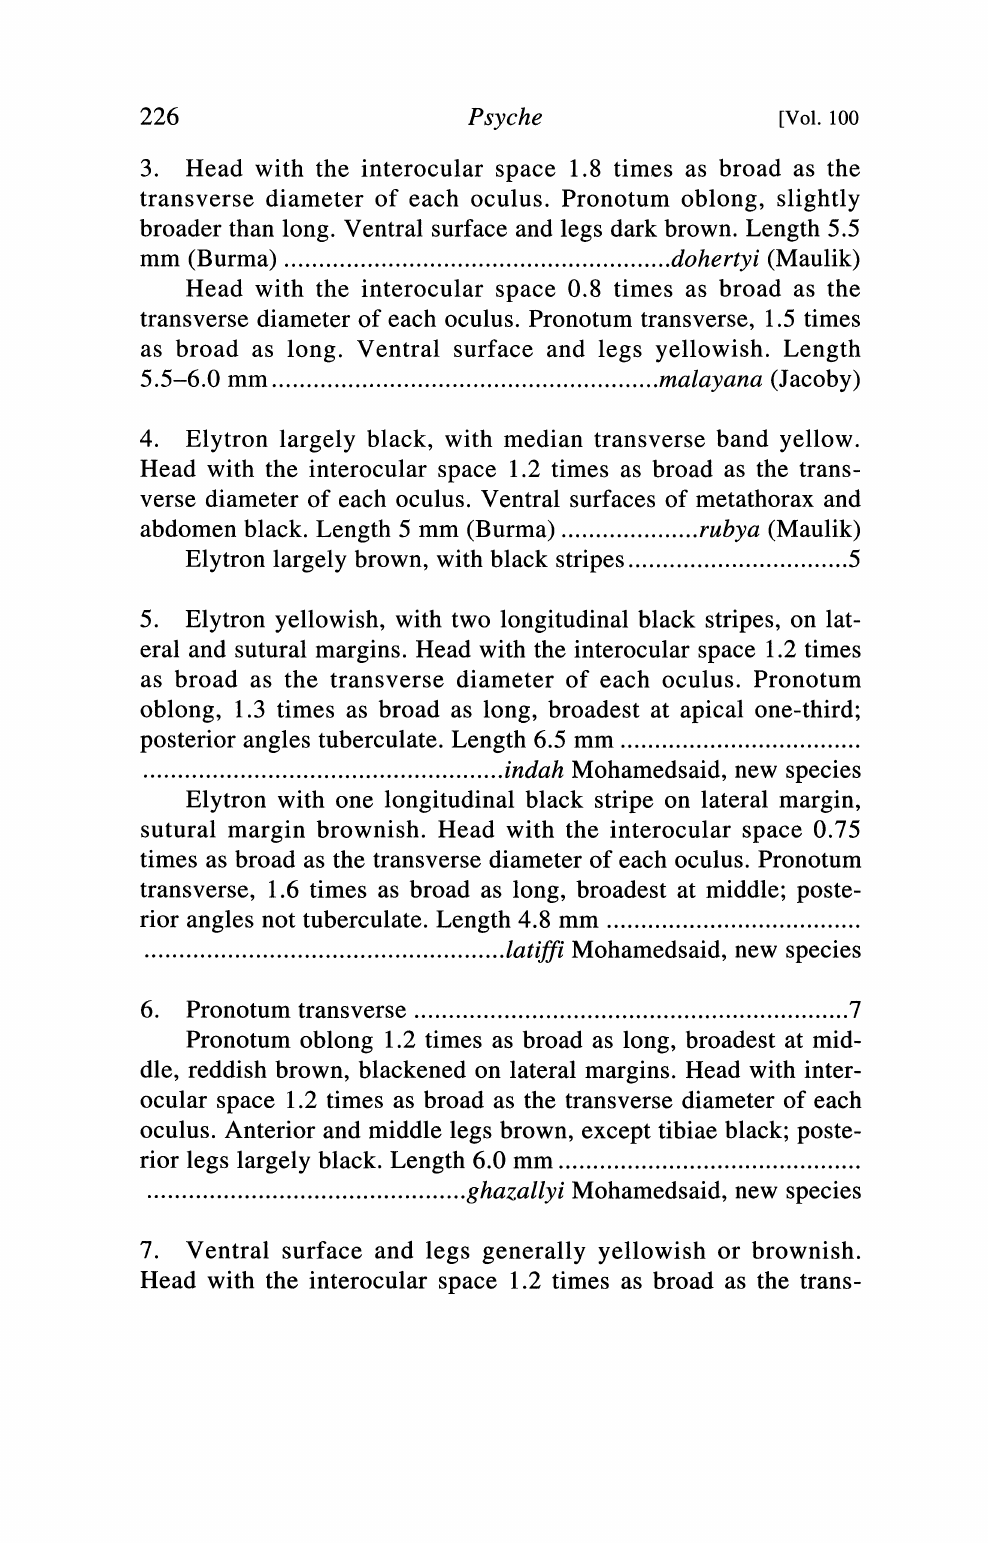
Pronotum oblong 1.2 times as broad as long, broadest at mid- dle, reddish brown, blackened on lateral margins. Head with inter- oculus. Anterior and middle legs brown, except tibiae black; poste- rior legs largely black. Length 6.0